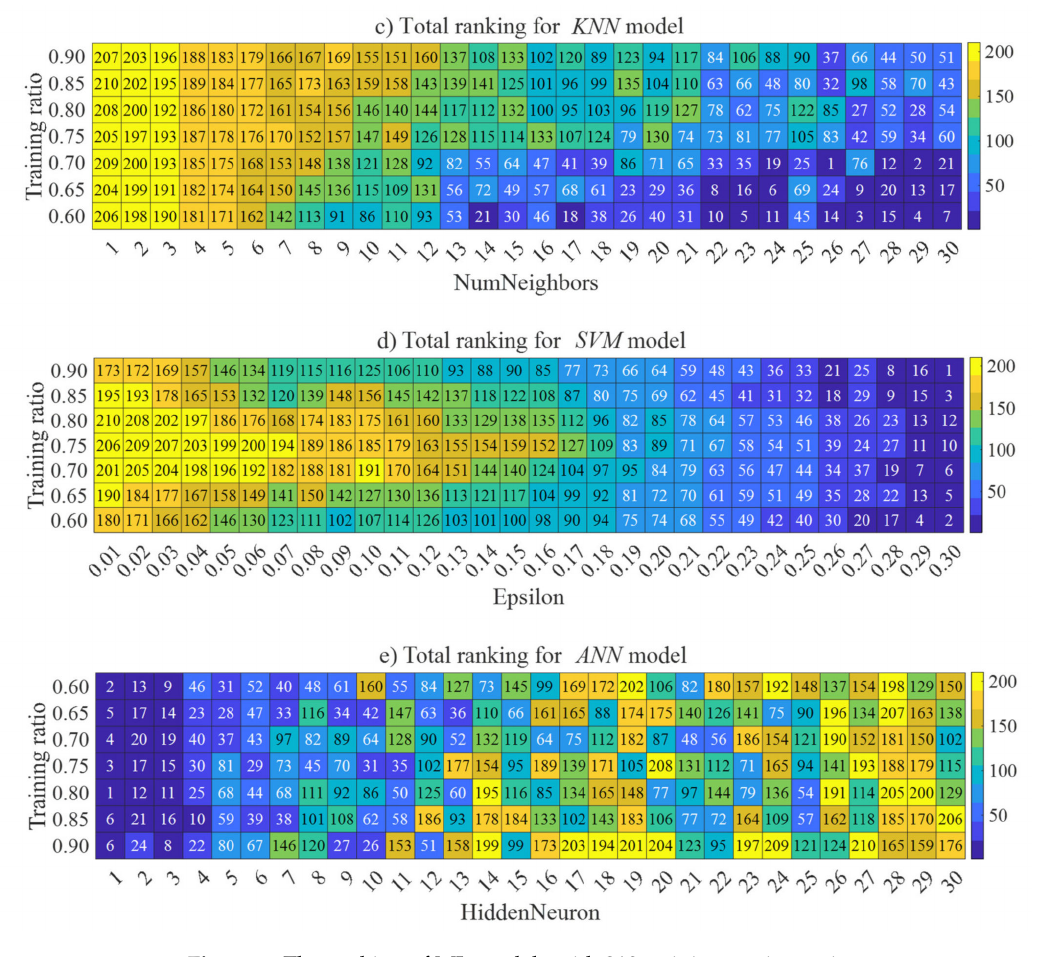
Figure 9. The ranking of ML models with 210 training-testing